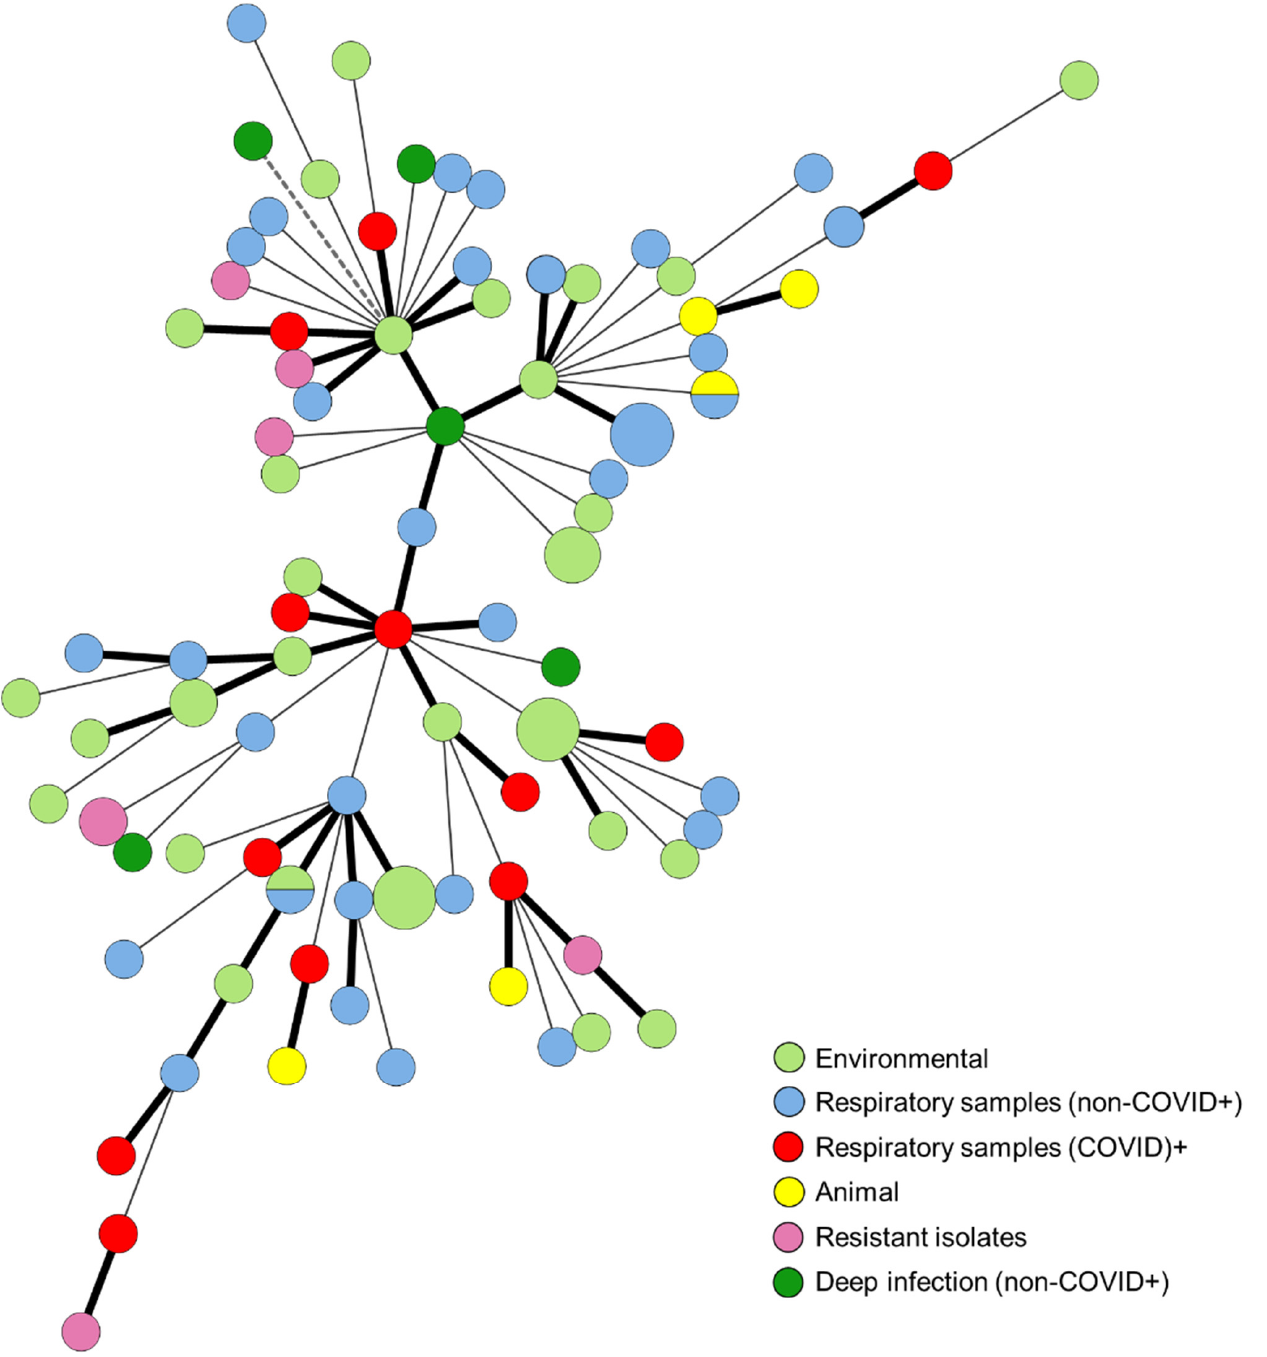
Figure 1. Minimum spanning tree constructed in Bionumerics 6.6. software (Applied Maths, bioMérieux SA, Marcy-l'Étoile, France) using a categorical similarity coefficient and an unweighted pair group method with arithmetic mean (UPGMA) analysis. The 85 different genotypes found are represented by each circle. The circle size is proportional to the number of isolates with each genotype. Each color represents a different isolate source, as shown in the bottom left corner. Each line represents the distance between genotypes: solid bold line–1 marker; solid line–2 markers, and dotted line–3 markers.